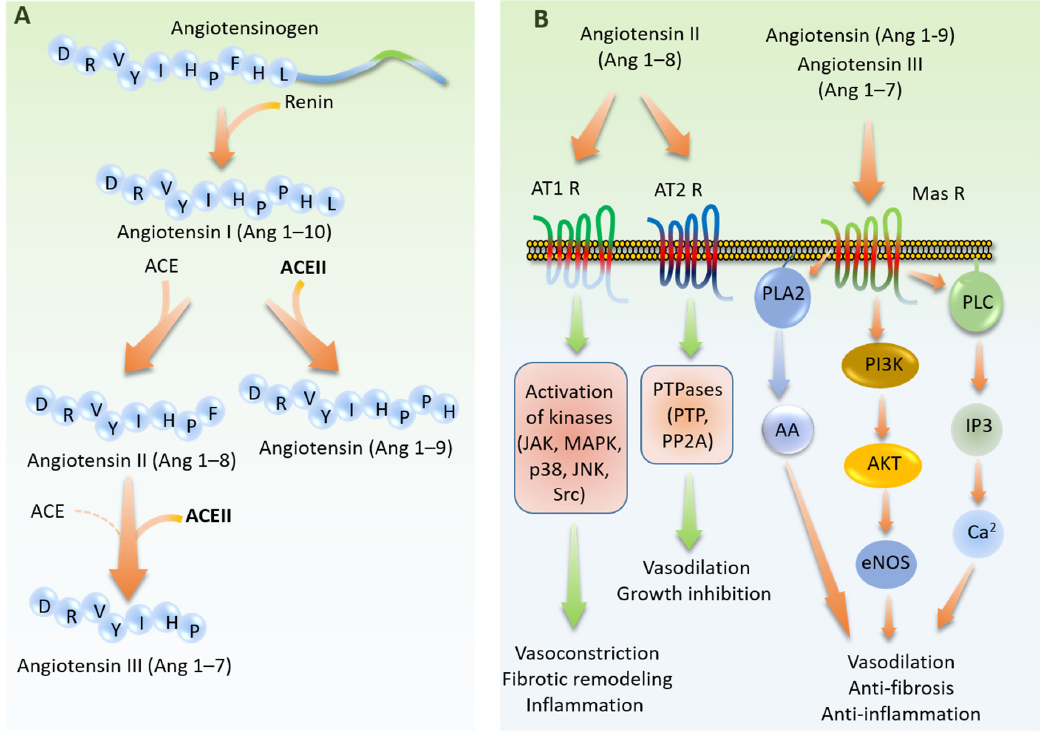
Figure 3. The physiological role angiotensin system in cardiovascular system. ( A ) Angiotensinogen is cleaved by renin and produces angiotensin I (Ang 1–10). Ang 1–10 is substrate for both ACE and ACE2. While ACE generates Ang 1–8, ACE2 cleaves Ang-10 and generates Ang 1–9. Ang 1–8 is a major substrate for ACE2 which produces Ang 1–7. ( B ) Ang (1–8) serves as a ligand for G-protein-coupled receptors (GPCRs), AT1R and AT2R. Activation of AT1R promotes vasoconstriction, fibrotic remodeling, and inflammation. Stimulation of AT2R leads to vasodilation and growth inhibition. On the other hand, peptides produced by ACE2 (Ang 1–9 and Ang 1–7) bind to GPCR, Mas receptor leading to its activation and promotes vasodilation, anti-fibrosis, and anti-inflammation effects. AA, Arachidonic acid.